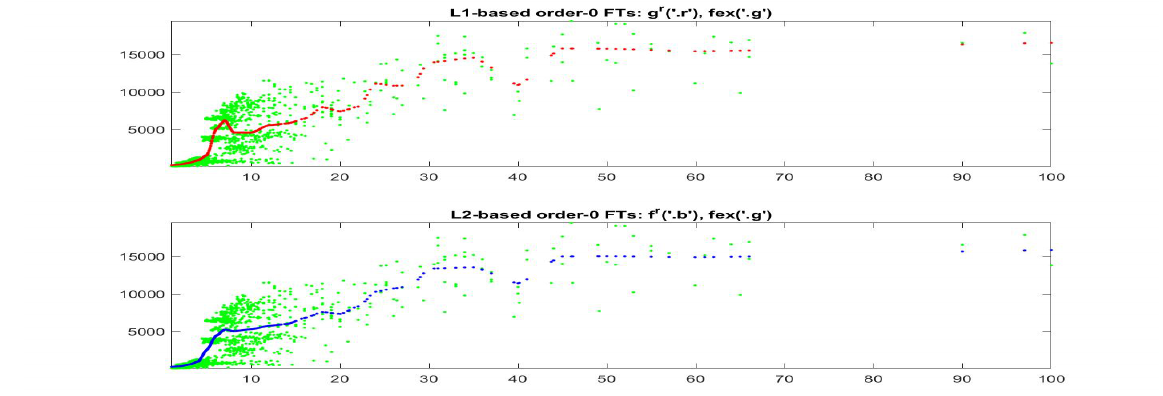
Figure 5. The figure shows (inverse) L 1 -norm (on top ) and L 2 -norm (on bottom ) iF-transform functions obtained for the observations ( GT 100 t , BitCoin t ) ; here, the daily Bitcoin prices are considered to be functions in the domain [ 0,100 ] of GT100.